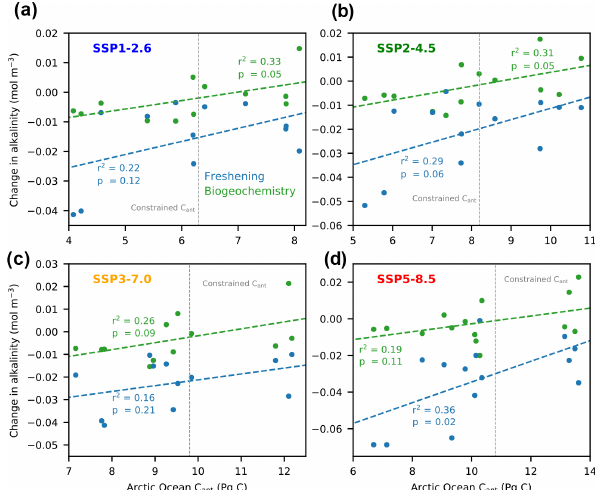
Figure 8. CMIP6 basin-wide changes in alkalinity ( A T ) averaged over the upper 1000m from 2002 to 2100 caused by freshwater dilu- tion (blue) and changes in biogeochemistry (green) against the Arc- tic Ocean C ant inventory for (a) SSP1-2.6, (b) SSP2-4.5, (c) SSP3- 7.0, and (d) SSP5-8.5. A T anomalies were decomposed by calculat- ing the temporal evolution of salinity-corrected alkalinity following Lovenduski et al.